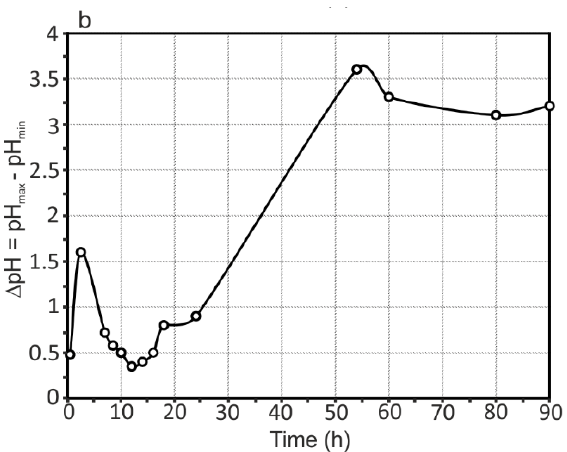
Figure 12. ( a ) pH max and ( b ) pH min as a function of time and ∆pH evolution with time for the 1579 Al alloy sample. This specimen varies very intensively, from 0.35 to 3.60, confirming the high corrosion activity of the welded 1579 aluminium alloy.